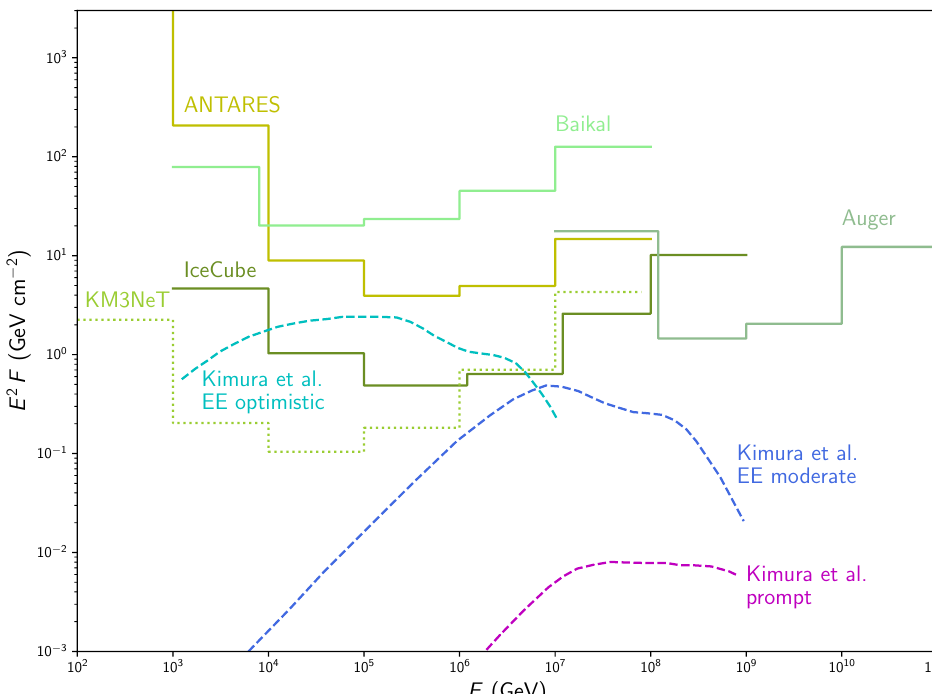
Figure 2. Fluence upper limits, per flavor, on the high-energy neutrino emission from experimental data assuming a 500s time window around the GW170817 event [61]. Baikal limits are from [62]. ± KM3NeT preliminary sensitivity, computed for an optimal zenith angle, is from [64]. Theoretical models for comparison are from [63]. Figure adapted from the work in